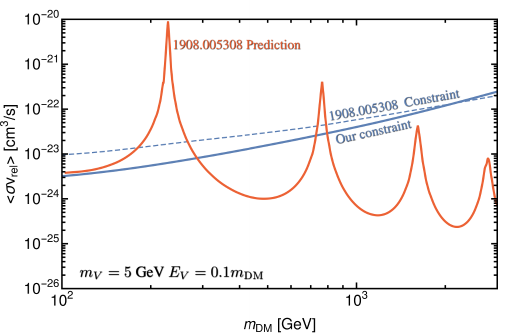
Figure 13: Constraint on the bound state formation considered in Ref. [ 58 ] from our analysis and compared to the approximate constraint derived in [ 58 ] using the results of [ 100 ] . Although the constraints here are in rough agreement, our constraints can be applied to a wider range of dark photon